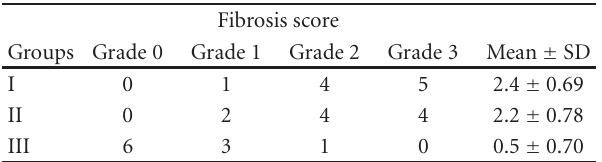
Table 4: Microscopic histopathological fibrosis severity grades and mean group scores.